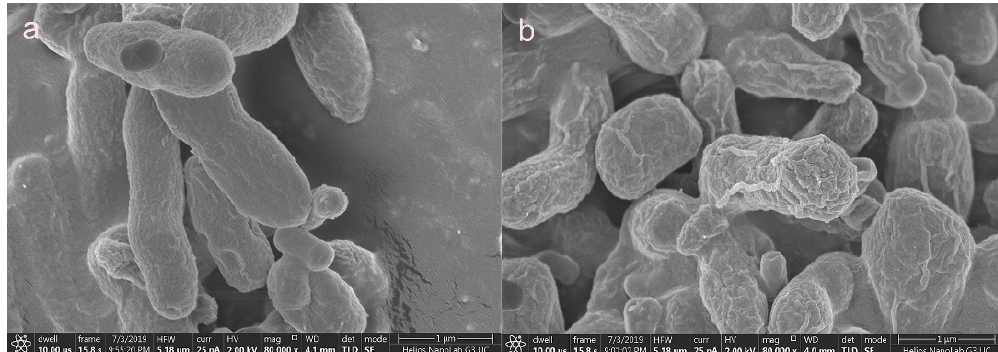
Figure 6. SEM images of Synechococcus PCC7002 ( a ) and Cs-loaded Synechococcus PCC7002 ( b ). Scale bars: ( a ) 1 μ m; ( b ) 1 μ m.